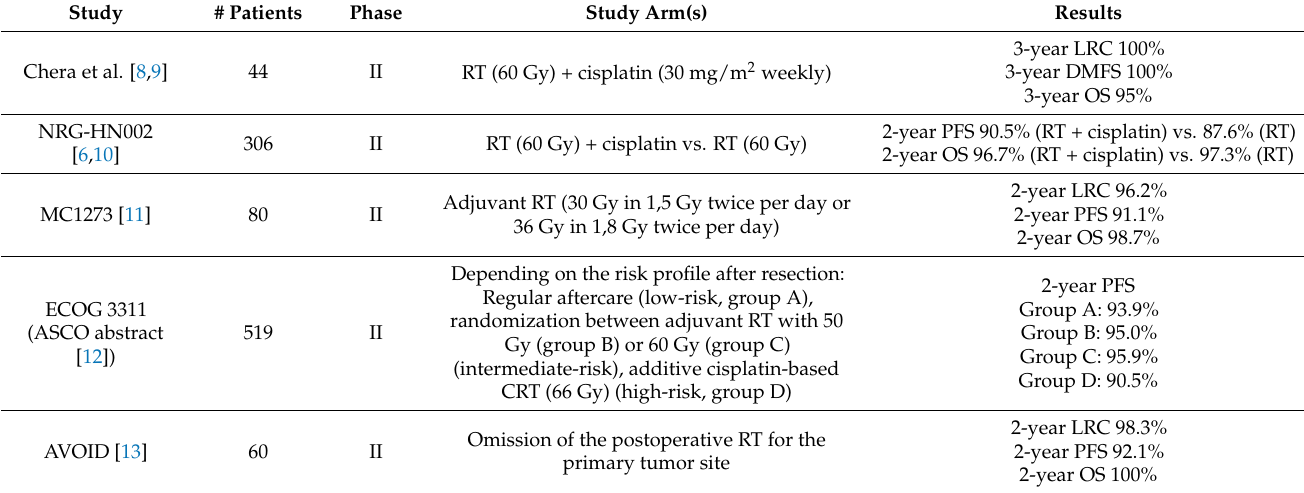
Table 1. Overview of important (chemo)radiotherapy de-escalation trials in which the radiation dose/volume was de-escalated. CRT = chemoradiation, RT = radiotherapy, OS = overall survival, PFS = progression-free survival, LRC = local/locoregional control, DMFS = distant metastasis-free